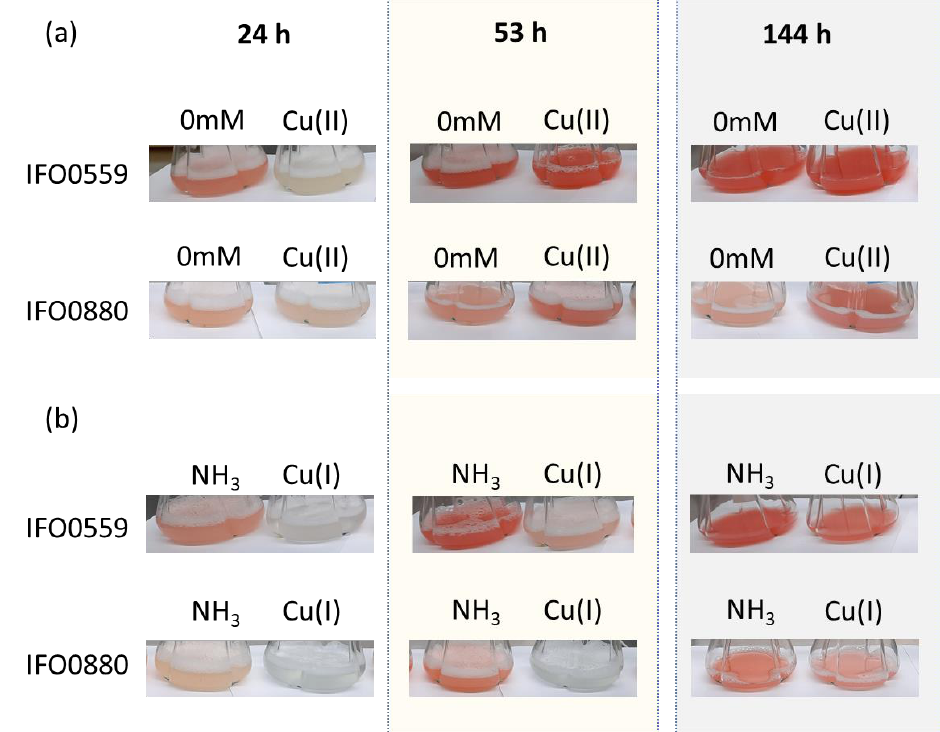
Figure 1. Visible changes in color and turbidity of Rhodosporidium toruloides IFO0559 and IFO0880 during shaking flask cultivation. ( a ) Cultivations without supplement (0 mM) versus with 0.5 mM Cu(II). ( b ) Cultivations with 0.03% ammonia (NH 3 ) versus with 0.03% ammonia (NH 3 ) and 0.5 mM Cu(I).